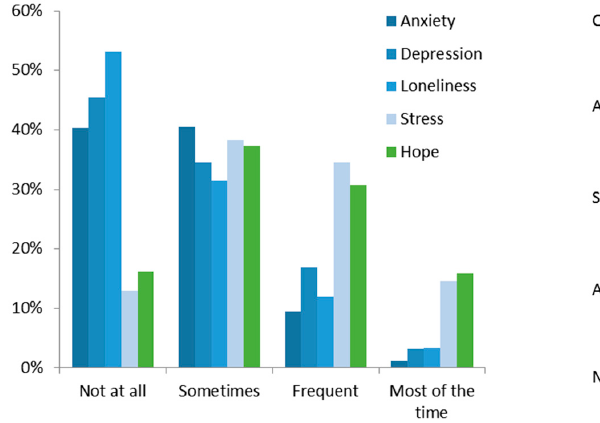
( B ) Figure 2. ( A ) Histogram of decisional conflicts within professional groups; ( B ) regional distribution of decisional uncertainty and conflicts in Germany (mean and 95% CI).